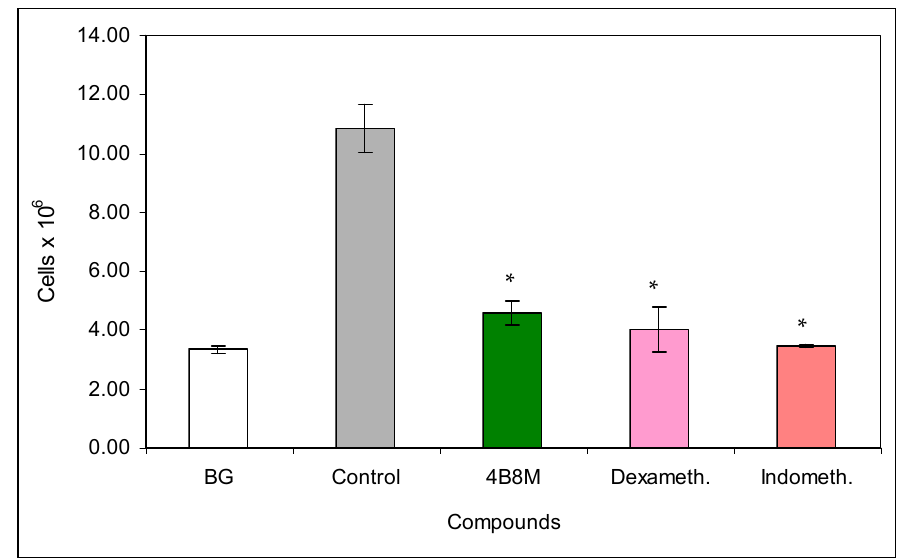
Figure 10. Effects of the compounds on cell numbers in the pleural exudates: the experiment was performed as described in Figure 9. The exudates from pleural cavities were centrifuged, cell pellets were diluted with Türk’s solution, and the cells were counted in a Bürker hemocytometer. The results are shown as 10 6 cells (mean values ± SE). * Control vs. compounds p < 0.05 (ANOVA).